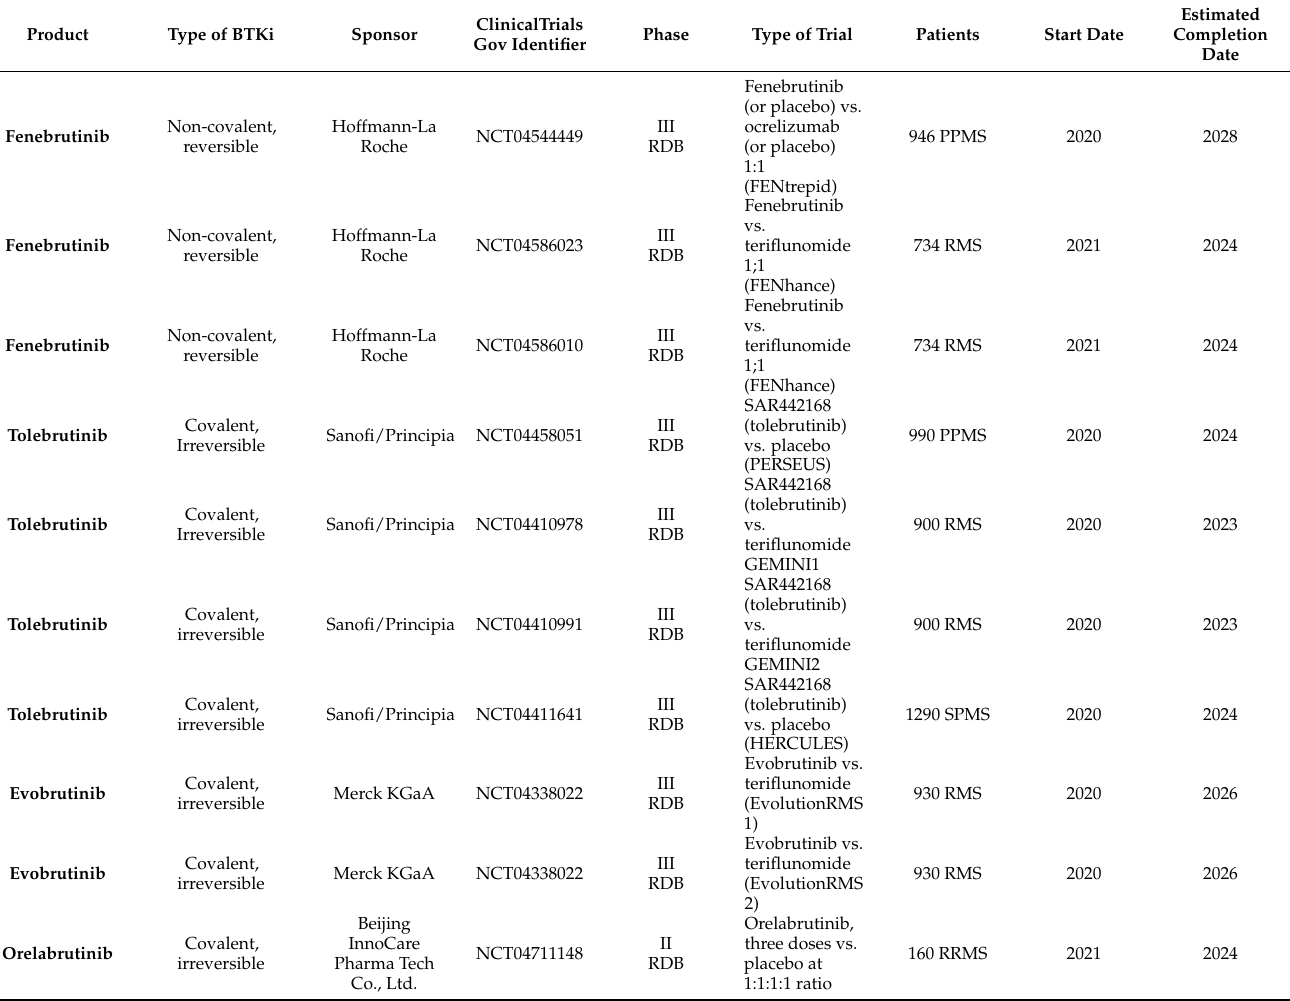
Legend to table. Clinical trials with BTK inhibitors for multiple sclerosis in 2021. RDB: randomized double-blind. PPMS: primary progressive multiple sclerosis. SPMS: secondary progressive multiple sclerosis. RMS: relapsing multiple sclerosis. RRMS: relapsing–remitting multiple